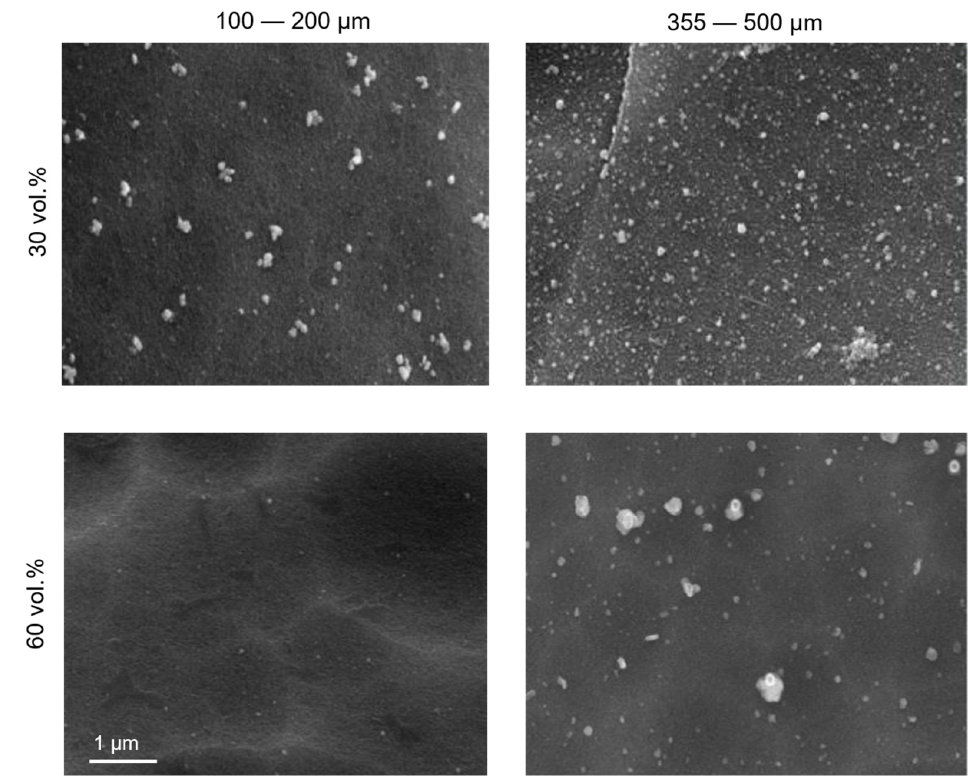
Figure 6. SEM of flat area of porous Ti substrates coated with AgNPs. Influence of the content and range of pore sizes. Note: all surfaces have previously been attacked with piranha. In addition, white contrast corresponds to agglomerated AgNPs.